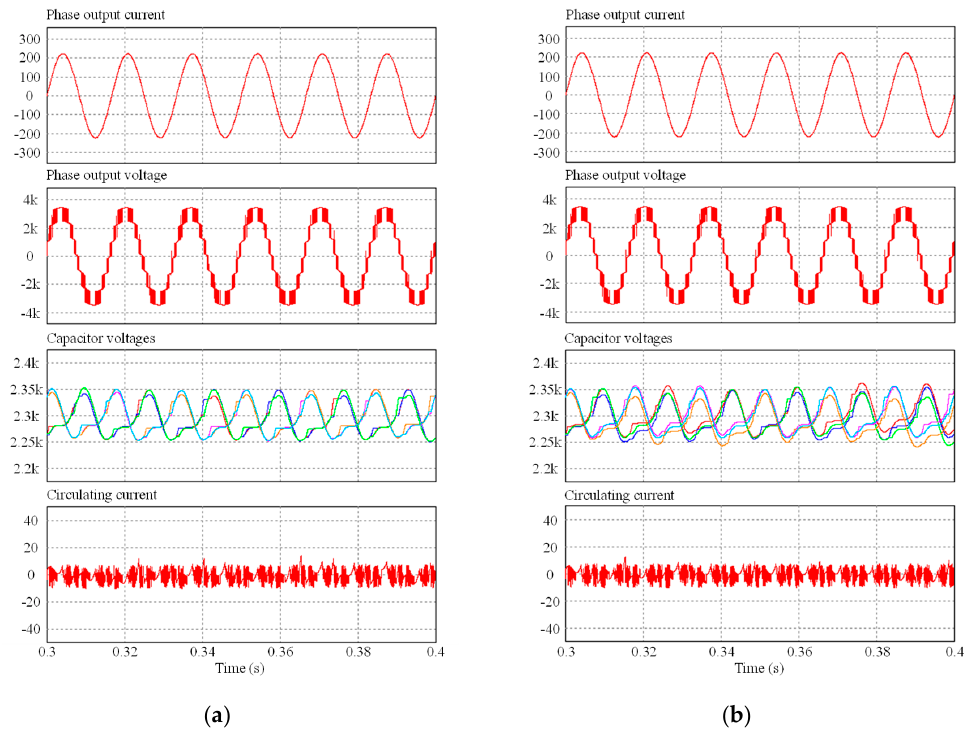
Figure 6. Simulation waveforms of phase output current, phase output voltage, SM capacitor voltages, and circulating current obtained from seven-level MMC ( N = 3) during steady-state operation: ( a ) without switching loss balancing control; ( b ) with switching loss balancing control.